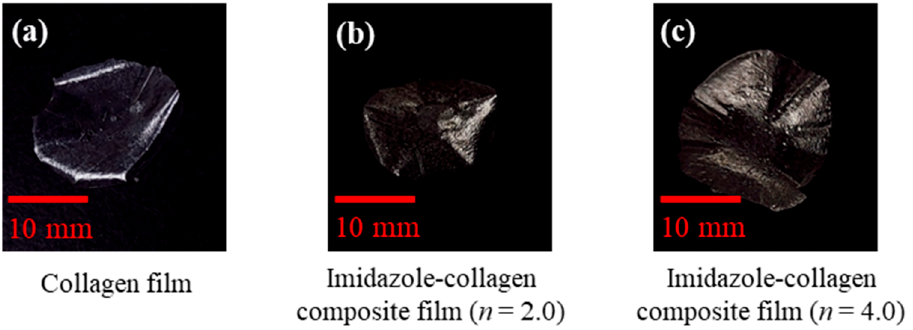
Figure 2. Photographs of collagen film and imidazole–collagen composite films. ( a ) Collagen film. ( b ) Imidazole–collagen composite film ( n = 2.0). ( c ) Imidazole–collagen composite film ( n = 4.0).